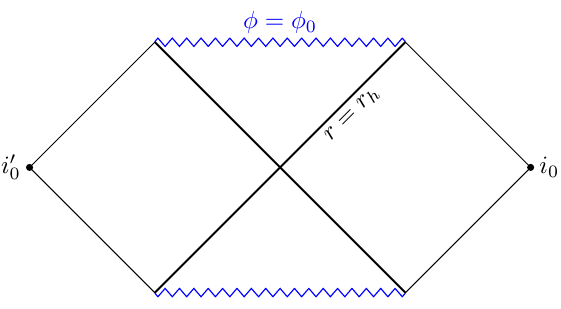
Figure 2 . Black hole in the CGHS model with a boundary. The (cid:12)eld equations break down at the line (cid:30) = (cid:30) 0 , indicating a